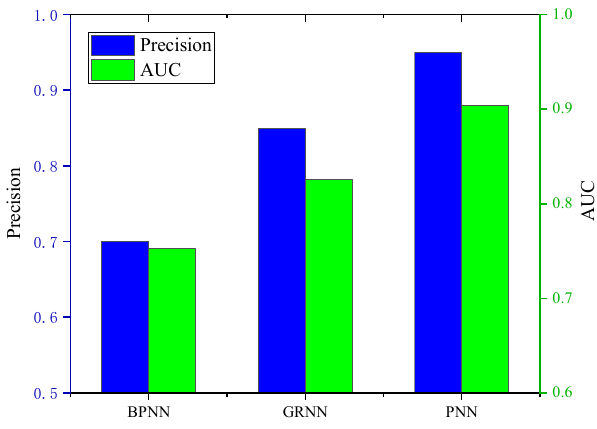
Figure 12. Comparison of ROC and precision of different classifiers.